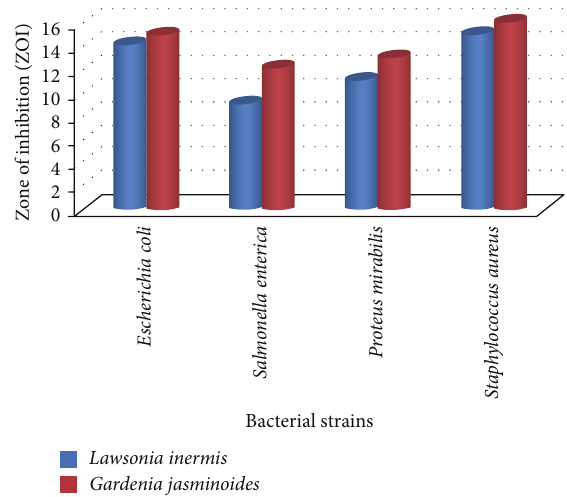
Figure11:Comparisonofantibacterial activity ofironnanoparticles of Lawsonia inermis and Gardenia jasminoides leaves extract against bacterial